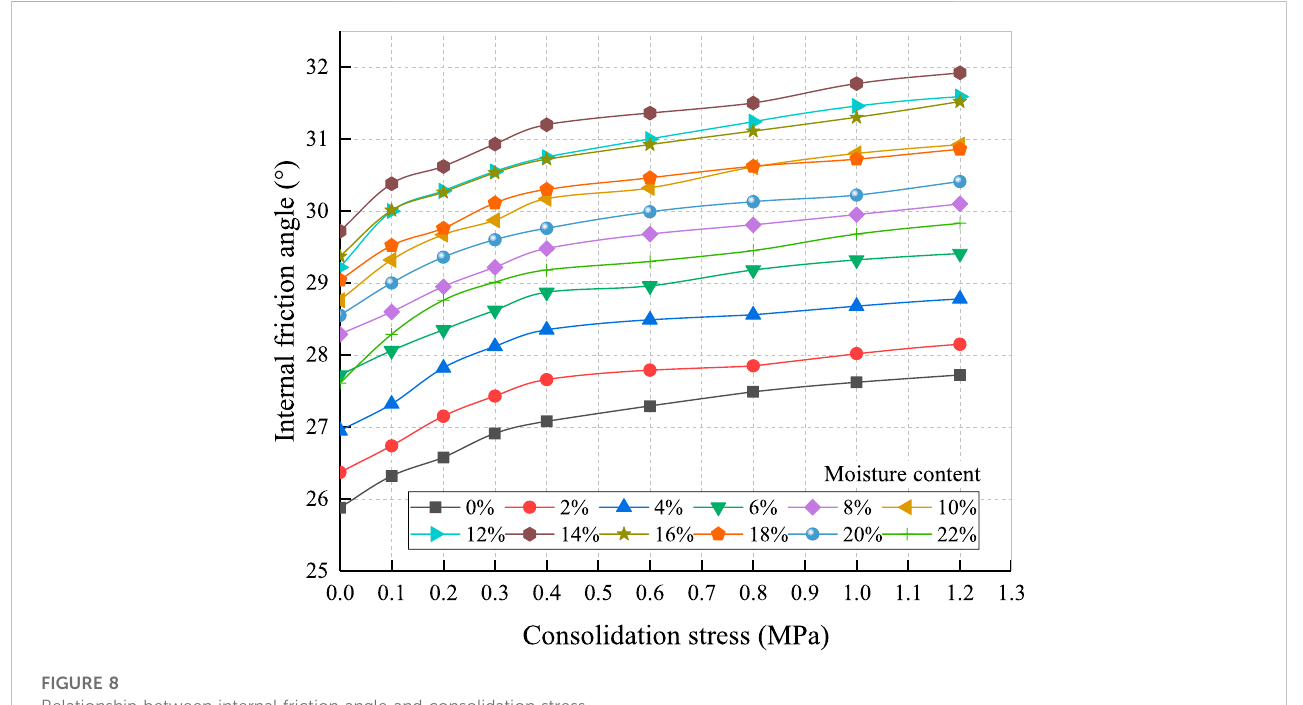
FIGURE 8 Relationship between internal friction angle and consolidation